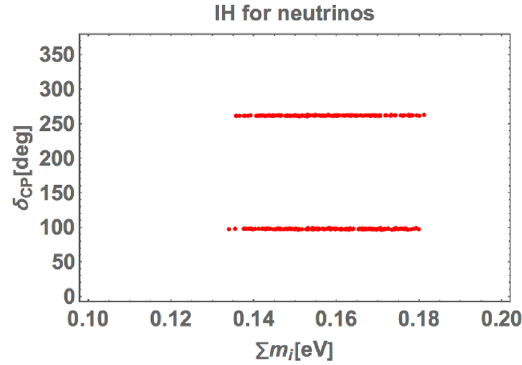
Figure 9 . The prediction of δ CP versus P m i for IH.